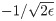
A graph depicting -1/2ϵ as a function of the inflaton ϕ for a model for which r0 = 0.001.The CMB interval is covered by ∼8 e-folds generated while the field changes by about Δϕ ∼ 0.1. Most of the e-folds are generated when ϕ reaches ∼0.4.